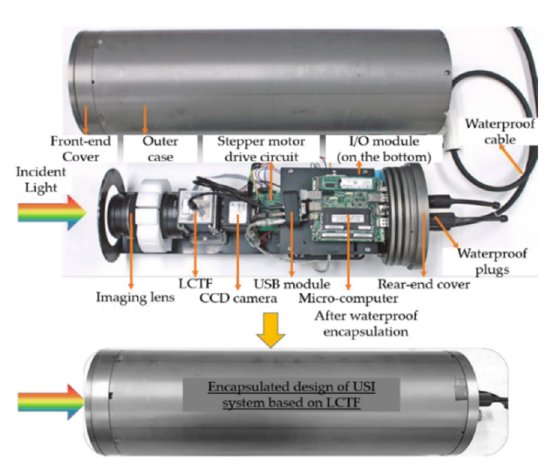
Figure 1. Encapsulated structure of the designed USI system. The hardware includes optical (lens, LCTF, and imaging sensor) and control (microcomputer, motor drive circuit, remote I/O circuitry, and voltage convertor) modules installed in a waterproof mechanical structure. Table 1. The detailed specification of parameters in the optical module of the USI system. Component